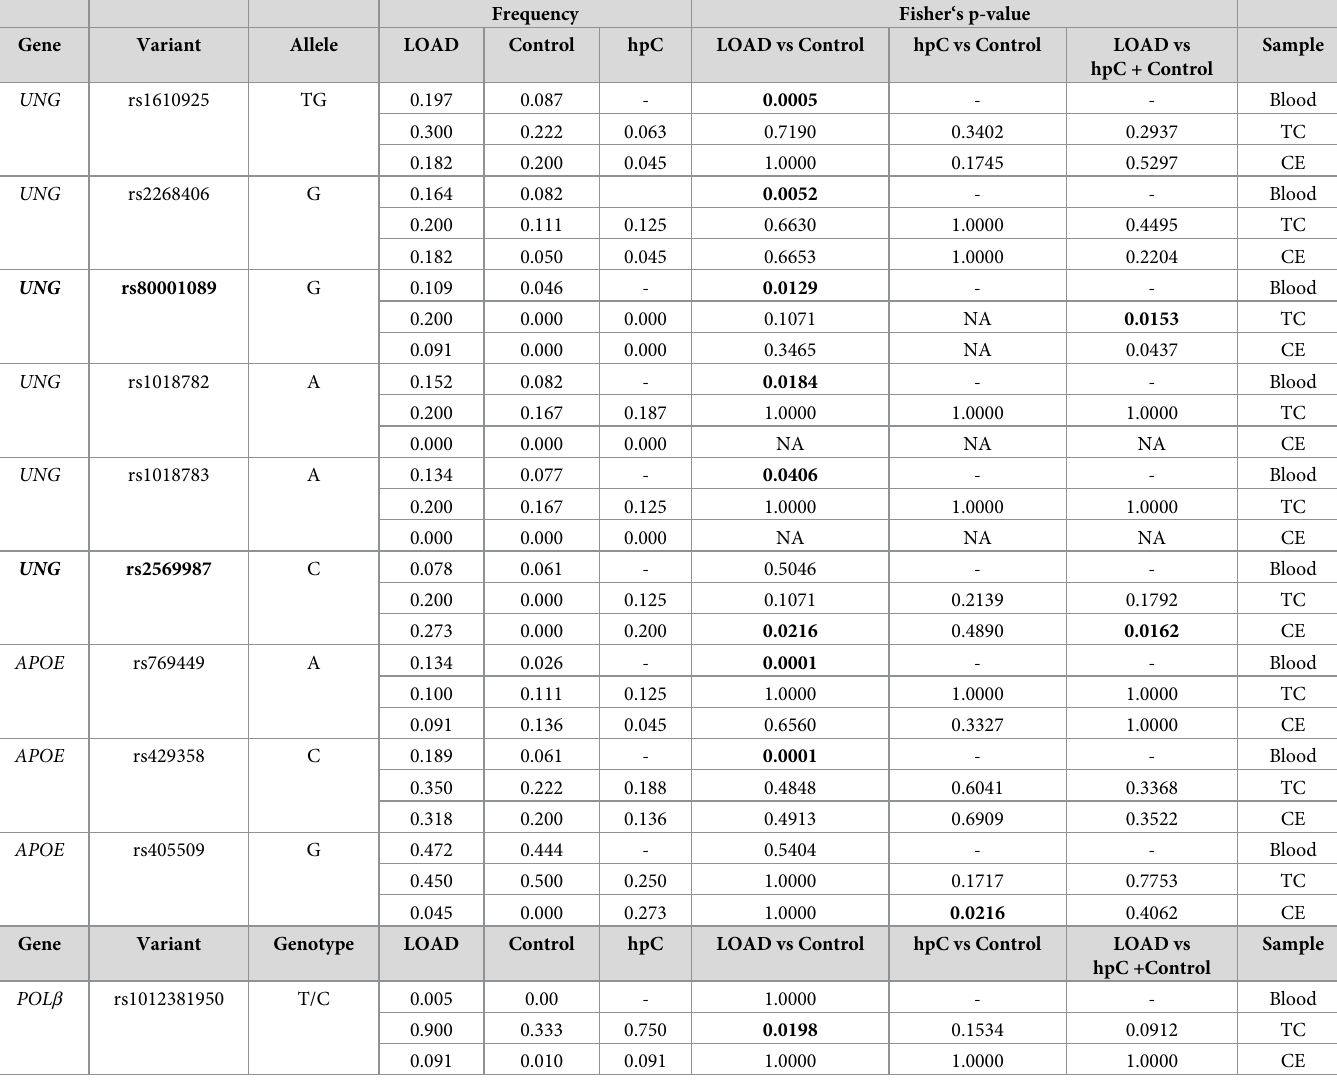
Table 12. Comparison of statistically significant variants of LOAD, Control and hpC in blood, CE and TC